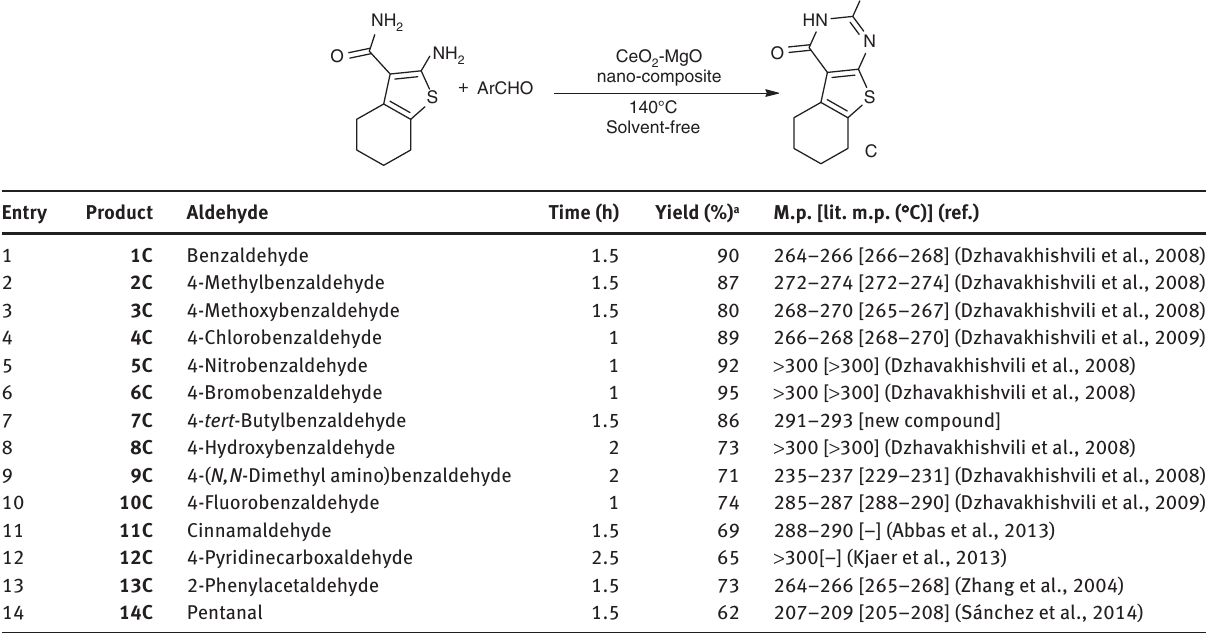
Table 2: Preparation of thieno[2,3- d ]pyrimidin-4(3 H )-one derivatives using ZnO-CeO